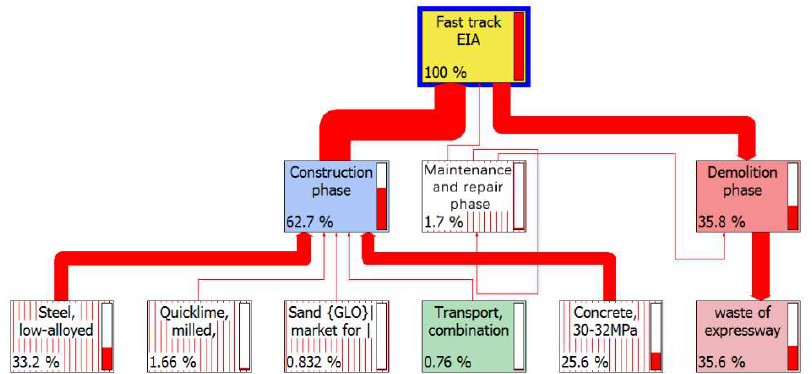
Figure 4. The network structure of environmental emissions for fast track transportation project in the life cycle. Note: Construction phase—accounts for 62.7% of the total environmental impact on the environment. Maintenance and repair phase—accounts for 1.7% of the environmental impact over the entire life cycle. Demolition phase—accounts for 35.8% of the environmental impact over the total life cycle.